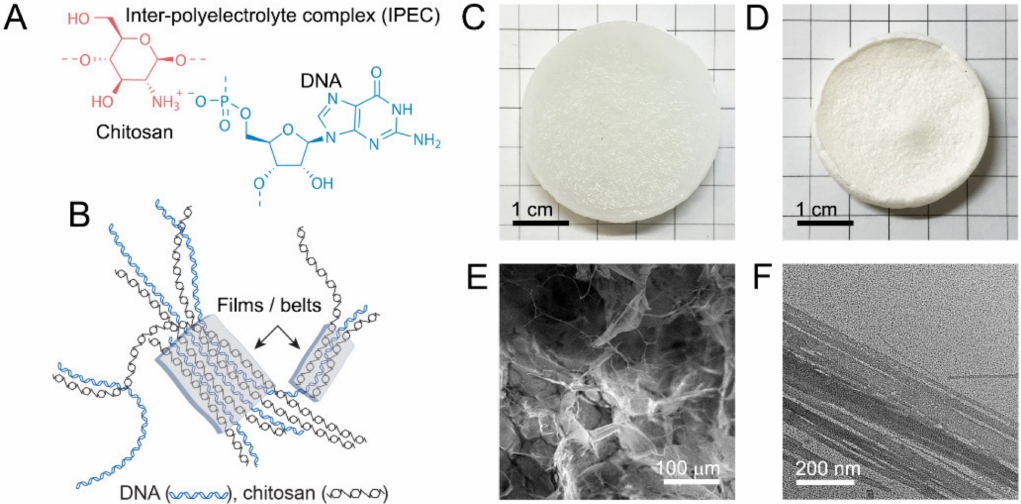
Figure 1. DNA–CS hydrogel formation and structure. ( A ) Formation of an ionic bond between chitosan and DNA monomer units. ( B ) Schematic representation of DNA and chitosan electrostatic interaction and formation of two-dimensional domains of belts or films. ( C ) Photographic image of DNA–CS hydrogel after washing. ( D ) Photographic image of freeze-dried DNA–CS hydrogel. ( E ) Typical SEM image of freeze-dried DNA–CS hydrogel. ( F ) Typical TEM image of DNA–CS films and fibrils in DNA–CS